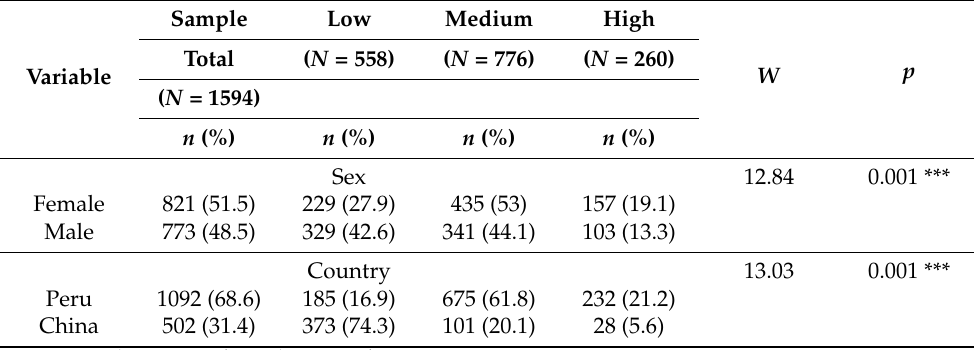
Table 1. Group comparisons of sex and country with risk perception.